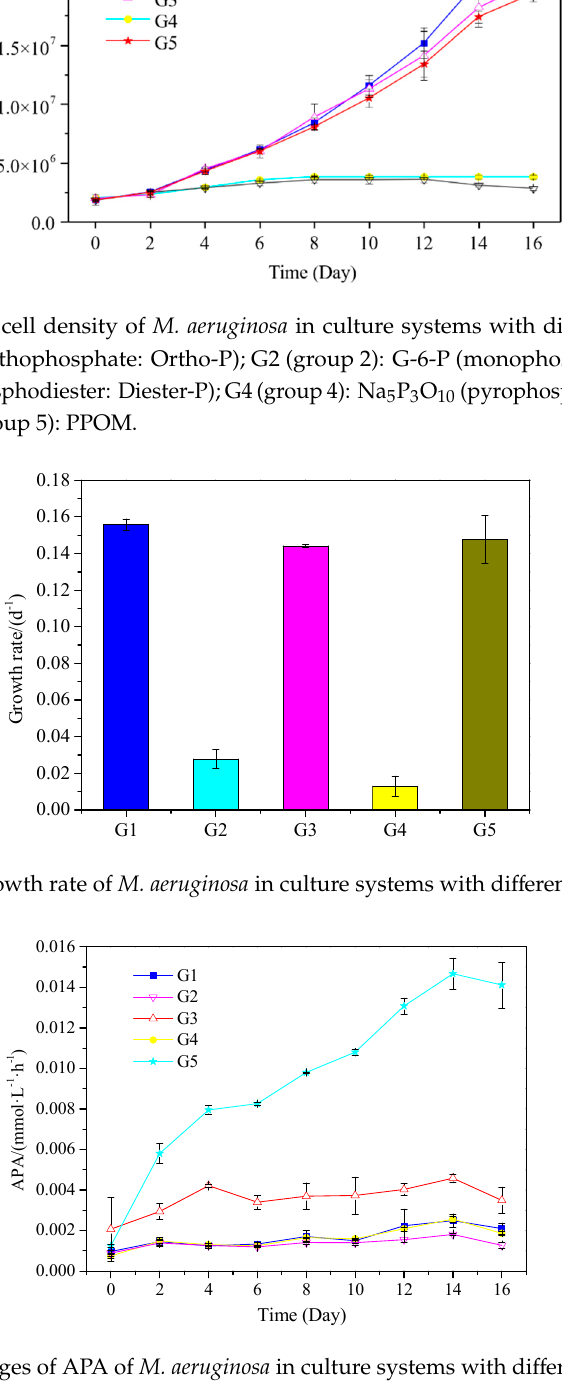
Figure 6. Changes of APA of M. aeruginosa in culture systems with different P source.